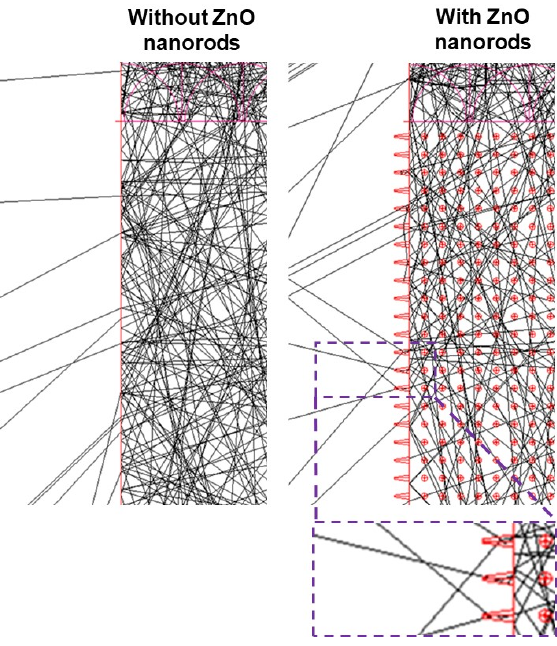
Figure 8. Effect of without/with ZnO nanorods on the LEE for USE-LEDs.